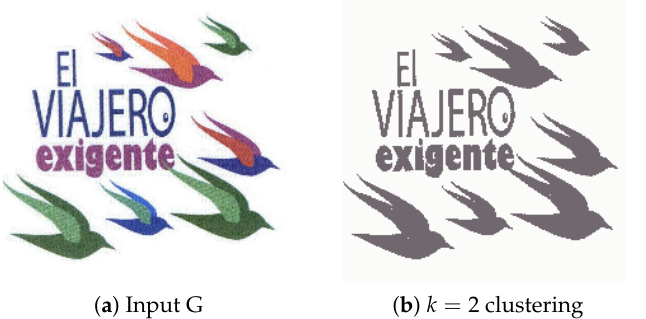
Figure 17. ( a ) Experiment G input; ( b ) Experiment G K-Means clustering ( k = 2).